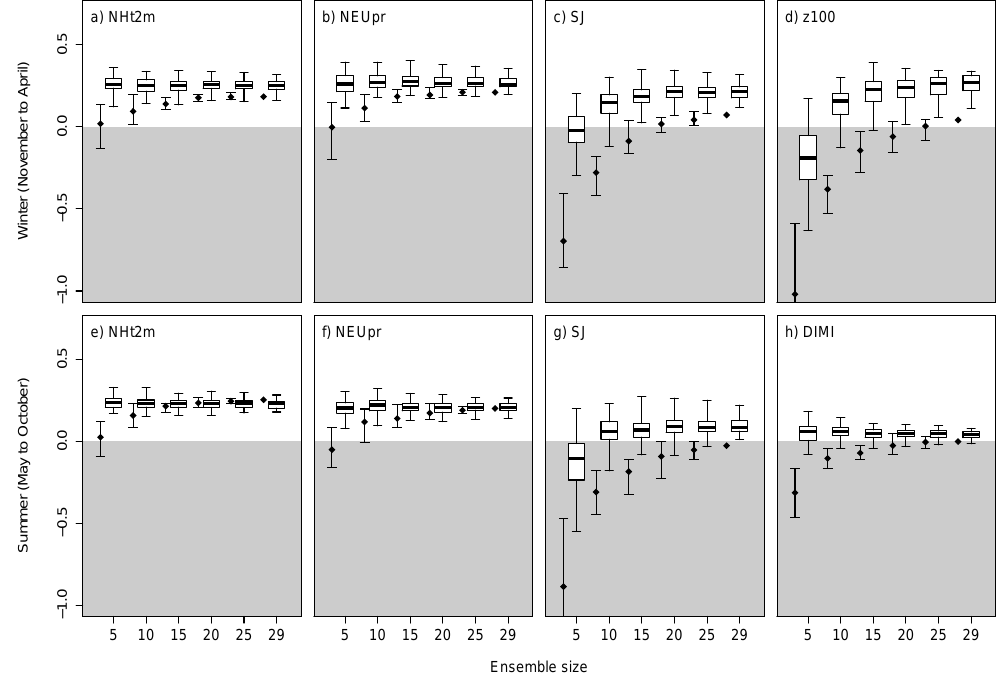
Fig. 7. Skill in dependence of ensemble size for different aggregated indicators. The boxes summarise the distribution of the mean squared error skill for individual simulations (10 times the number of ensemble members). The black bars denote the spread of skill for the ensemble mean for the 10 different realisations of varying ensemble size; the black diamond indicates the average ensemble mean skill over these 10 realisations. For 29 ensemble members, there is only one analysis.